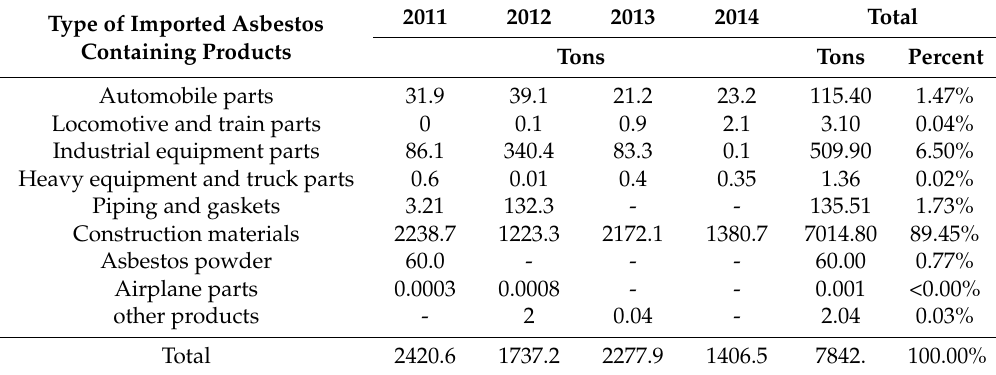
Table 2. Consumption of asbestos-containing materials in Mongolia between 2011 and 2014 by